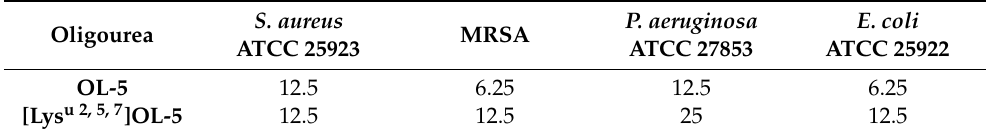
Table 2. Antibacterial activity of the urea-based foldamer OL-5 and its previously reported Lys u counterpart (MIC in µ g/mL). Each foldamer was incubated for 24 h at 37 ◦ C in 100 µ L of Mueller– Hinton broth (MHB) medium with the bacterial strain. The control is composed of the bacterial suspension mixed with PBS (=corresponds to 100% growth). The lowest concentration for which bacterial growth is 0% corresponds to the MIC of the tested compound. Each value corresponds to the mean value of 3 samples. S. aureus Oligourea ATCC